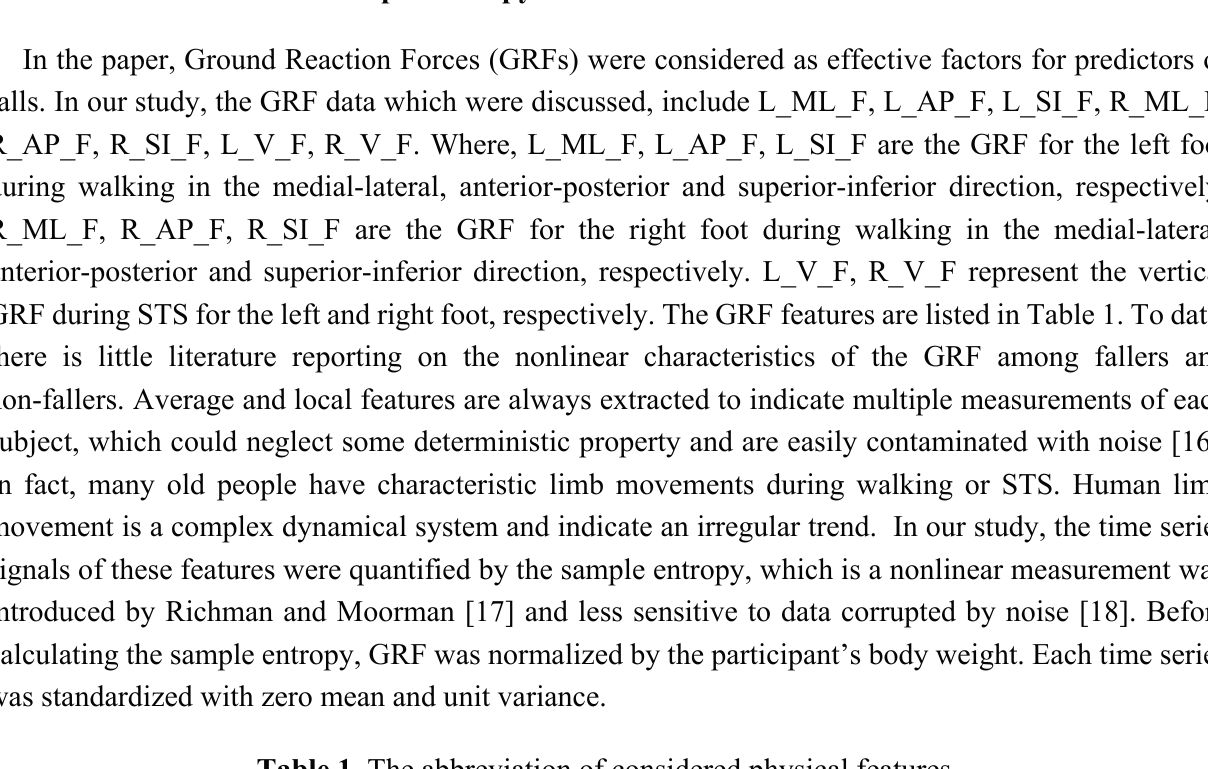
Table 1. The abbreviation of considered physical